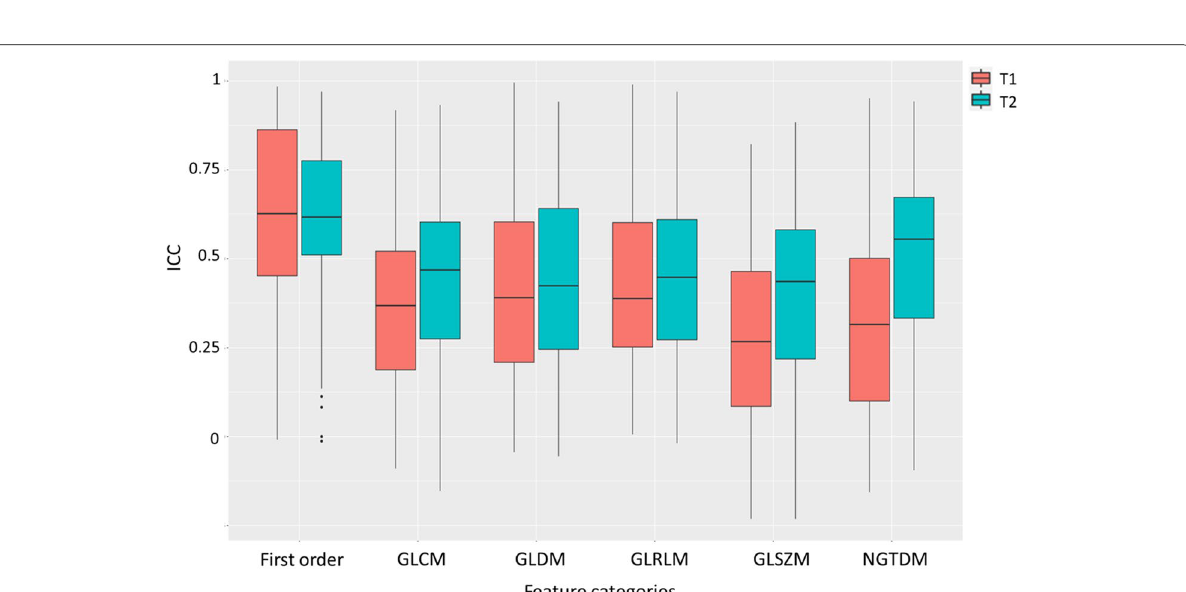
Fig. 3 Boxplots of ICC values for different radiomics feature categories in all VOIs for both pulse